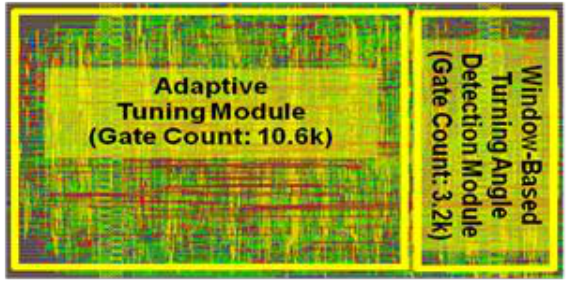
Figure 6. Layout of the proposed biomedical processing engine.